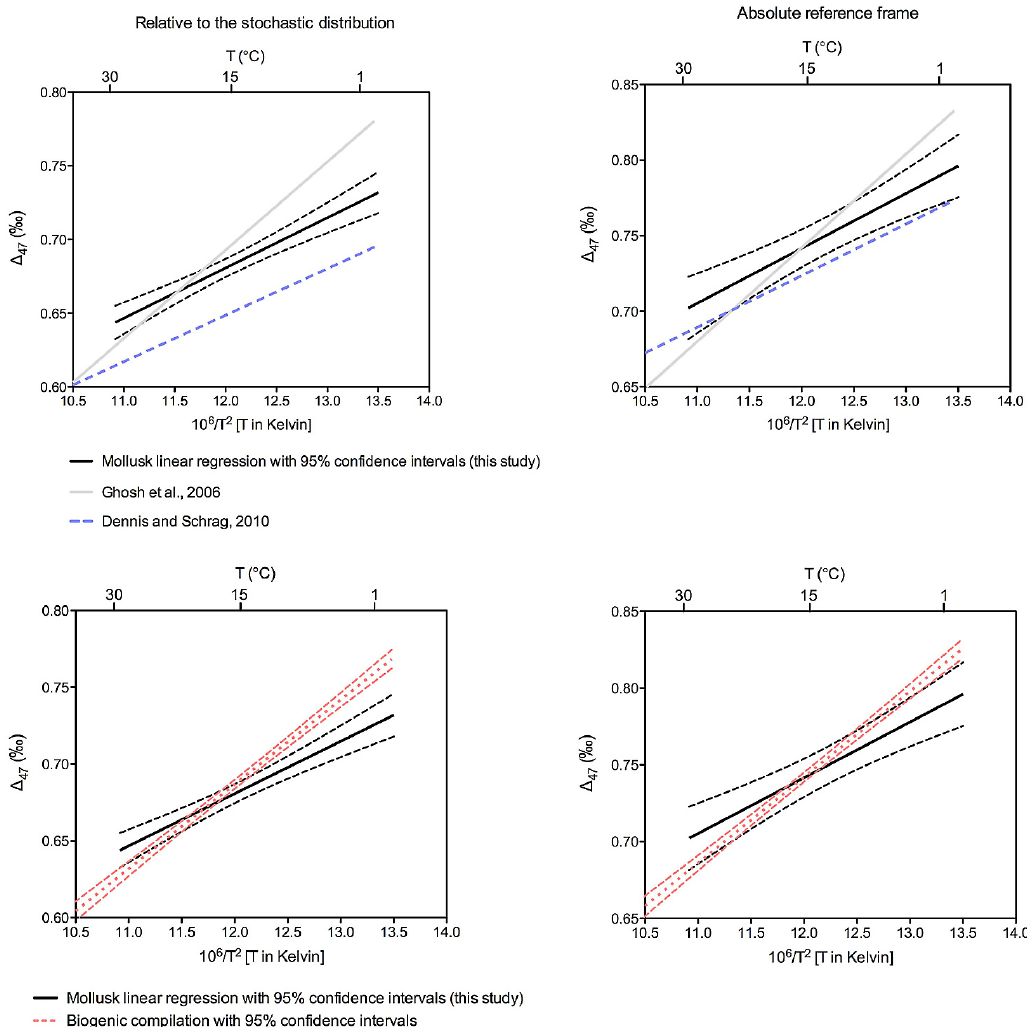
Fig. 3. Comparison of bivalve 1 47 measurements to previously published calibration data. Here we compare the linear regressions through our mollusk data shown in Fig. 2 to published calibration lines, relative to both the stochastic distribution (left panels) and the absolute reference frame (right panels). In all cases a correction of 0.08‰ was made to compare mollusk data to older data collected in our laboratory using 25 ◦ C acid digestion reactions. Mollusk calibration lines have a clearly shallower slope than the inorganic calcite calibration line of Ghosh et al. (2006) and have a similar slope to the calibration of Dennis and Schrag, but with a slight offset to that calibration (Dennis and Schrag, 2010). The mollusk calibration line is also significantly shallower than the linear regression through the compilation of other published materials from our laboratory (bottom panels), with previously published data plotted in this graph given in Table